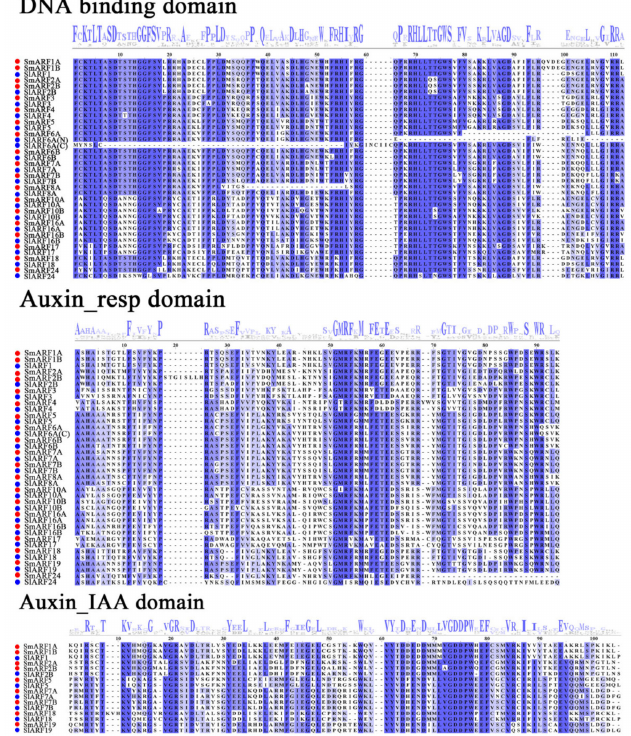
Figure 1. Multiple alignment profiles of the B3 (DNA binding domain), auxin_resp, and CTD (Aux/IAA–binding) domains of the SmARF proteins obtained with the Jalview program. Red and blue codes were used to distinguish the eggplant and tomato sequences. All sequences show high levels of amino acid conservation in blue. The logo at the top shows amino acids, and large letters represent greater conservation.